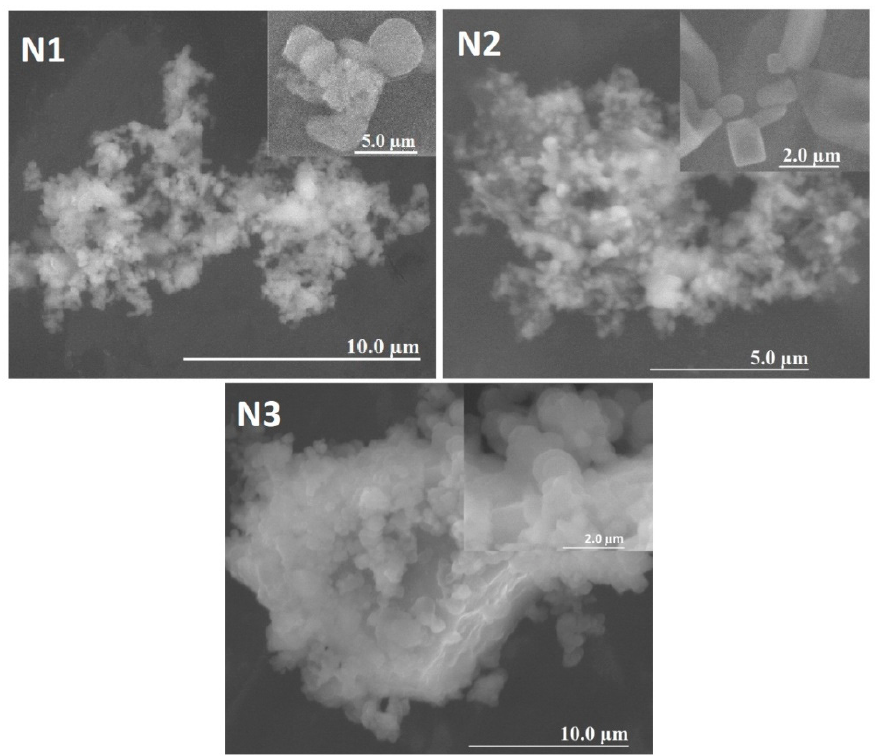
Figure 2. ESEM images of the surface of the ZnO materials modified with silanic precursors N1 (TEOS/OTES), N2 (TEOS/GPTMS), N3 (TEOS/ODTES).